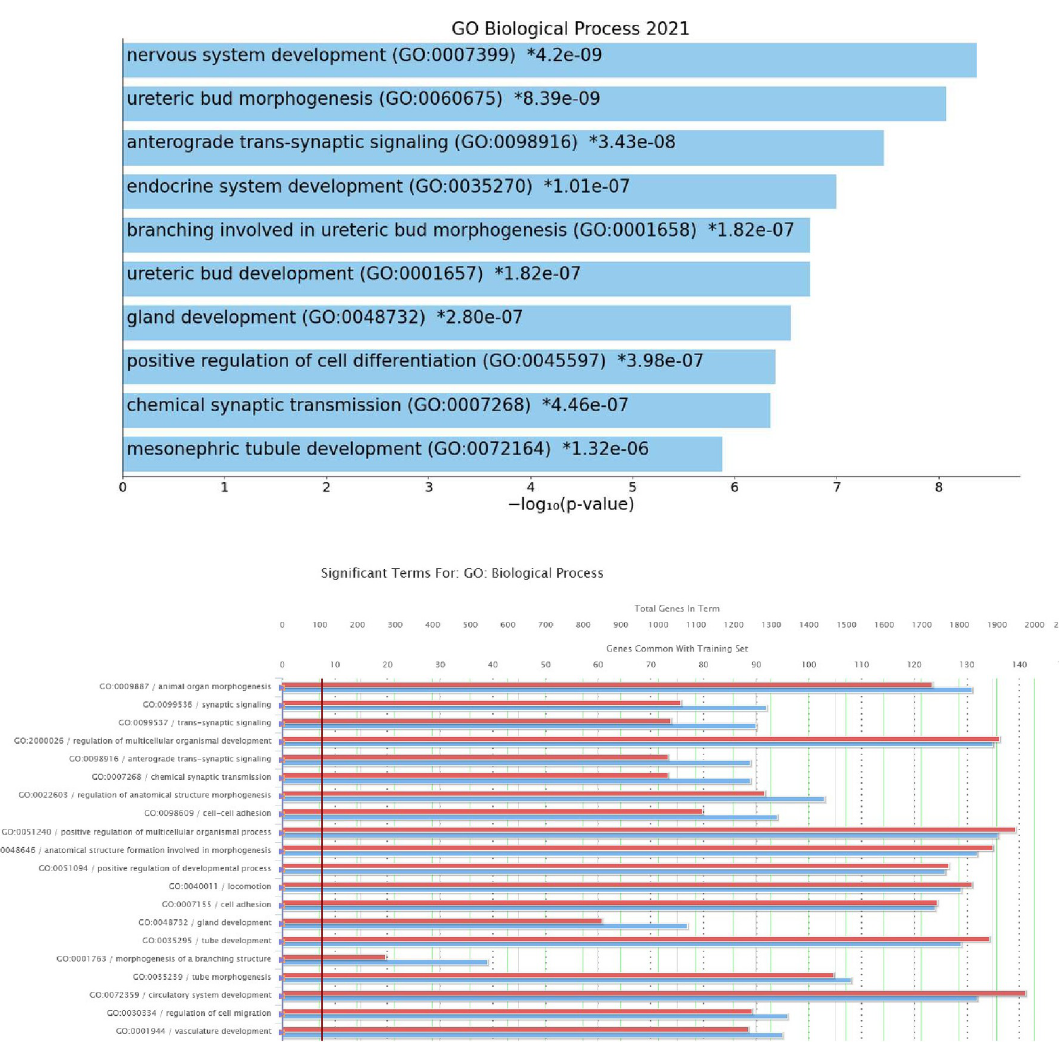
Fig 12. Go BP-term analysis of the WT signature genes. A) the 10 top terms using EnrichR and B) the 20 top terms using ToppGene.